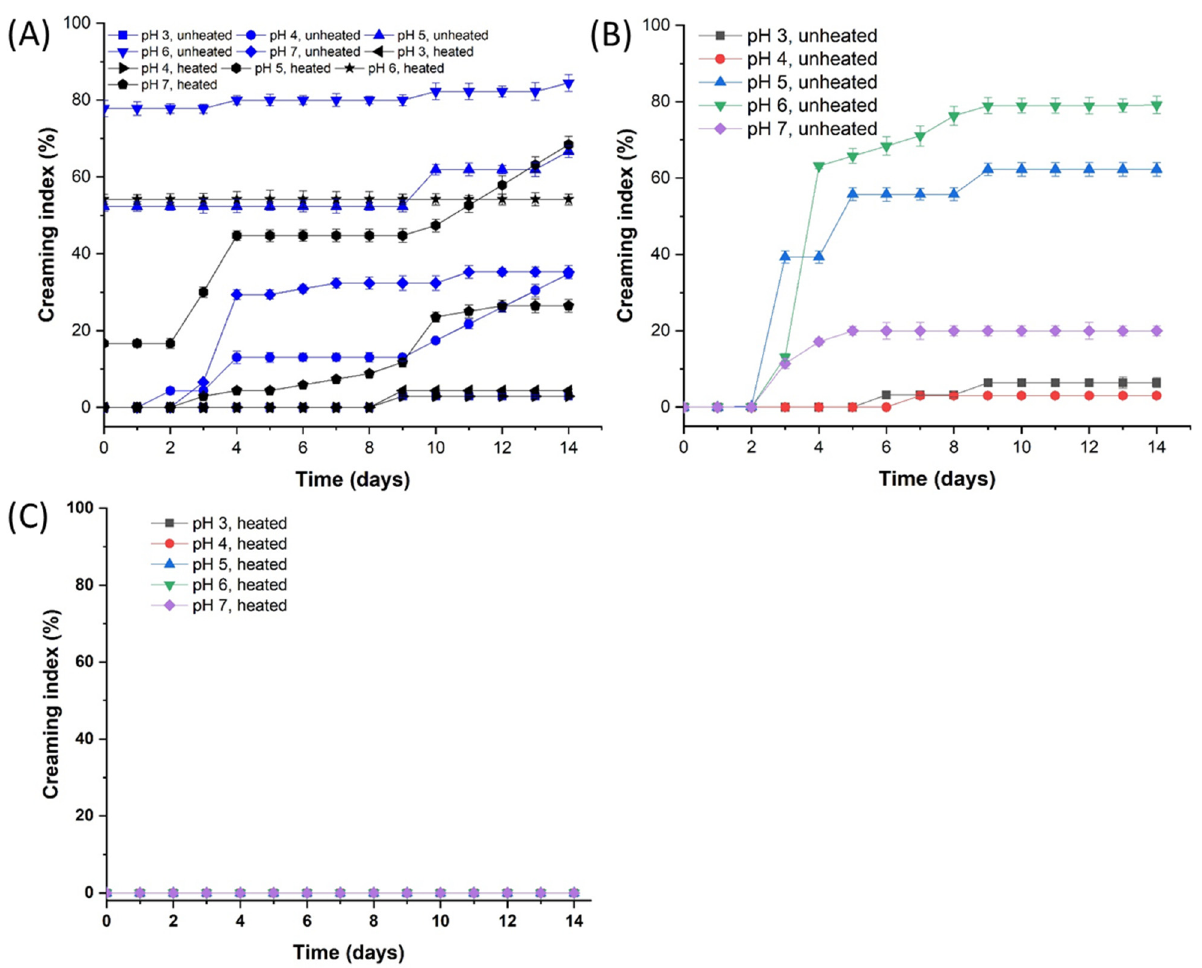
Figure 4. Creaming index (CI) of the O/W emulsions stabilized by PAs alone ( A ) and PA/DS soluble complexes (( B ) unheated; ( C ) heated) at pH 7–3 upon storage for 14 days. complexes (( B ) unheated; ( C ) heated) at pH 7–3 upon storage for 14